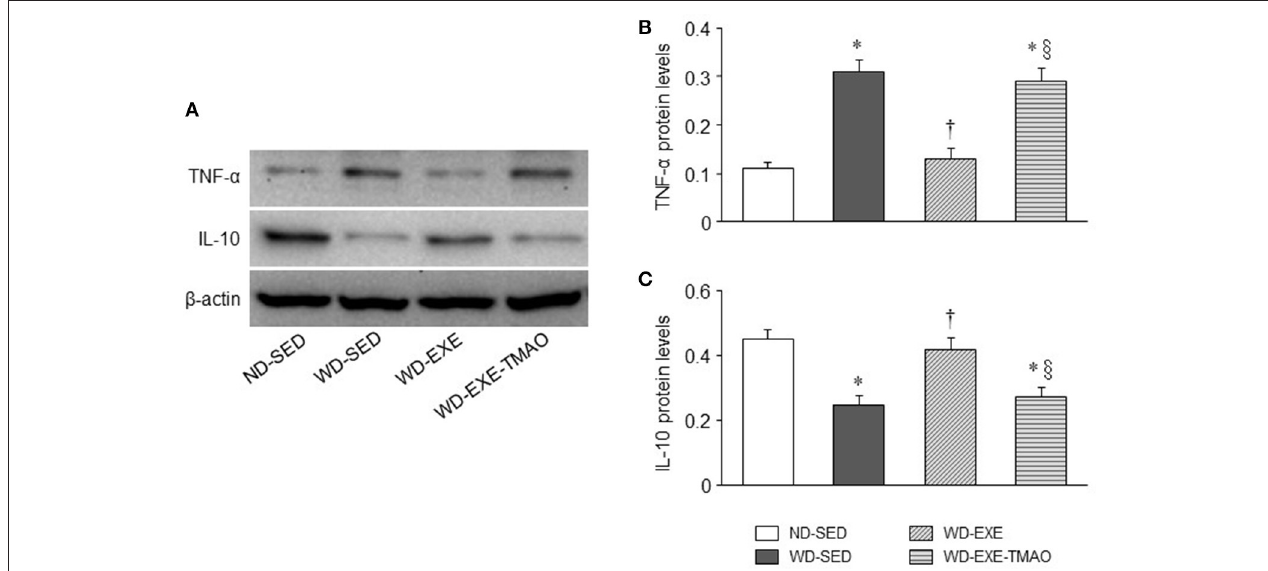
FIGURE 5 | Effects of voluntary exercise and TMAO supplementation on myocardial inflammatory cytokines in mice fed a western diet (WD). (A) Representative Western blots of inflammatory cytokines from each group. Compared with normal diet (ND)-sedentary mice, WD-sedentary mice exhibited increased protein levels of pro-inflammatory cytokines tumor necrosis factor (TNF)- α (B) and decreased protein levels of anti-inflammatory cytokine IL-10 (C) . WD-induced changes in both inflammatory cytokines were prevented by voluntary exercise but reversed by concomitant administration of TMAO in mice fed a WD. Sedentary: SED; voluntary exercise: EXE. Data are presented as mean ± SE ( n = 10 for each group). * P < 0.05 vs. ND-SED; † P < 0.05, WD-EXE vs. WD-SED; § P < 0.05, WD-EXE-TMAO vs.